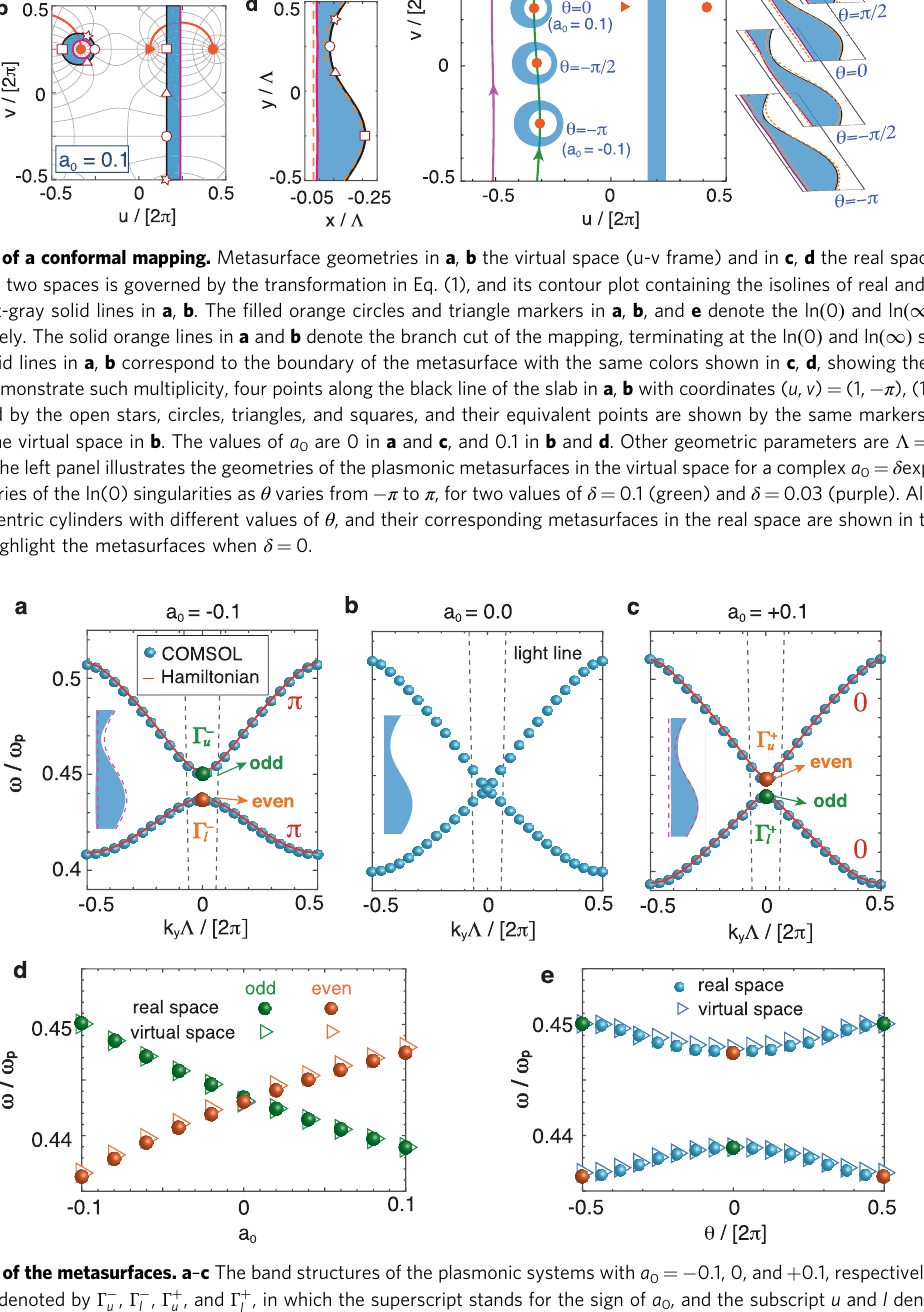
Fig. 2 Band structures of the metasurfaces. a – c The band structures of the plasmonic systems with a 0 = − 0.1, 0, and + 0.1, respectively. The states at the Γ -point in a and c are denoted by Γ (cid:2) Γ (cid:2) Γ þ Γ þ a u and l denotes the upper and u , l , u , and l , in which the superscript stands for the sign of 0 , and the subscript lower band. The gray dashed lines denote the light line, and the red solid lines are calculated via the Hamiltonian model. The insets in a – c show the schematics of the respective plasmonic metasurfaces, where the dashed lines highlight the metasurface boundary when a 0 = 0. The material of the metasurfaces is described by a lossless Drude model with plasma frequency ω p = 2 eV, while the background medium is vacuum. All other geometric parameters are the same as Fig. 1. d Eigenfrequencies at the Γ -point calculated in real space ( fi lled circles) and in the virtual space (triangles) with a 0 changing from − 0.1 to + 0.1. The color of the markers denotes the symmetry of the eigenstates, i.e., orange (green) represents the even (odd) mode. e The Γ -point eigenfrequencies calculated in the virtual space (triangles) and the real space ( fi lled circles) with δ = 0.1 as a function of θ , showing that the bandgap is always open in this case. All the calculations are for transverse magnetic modes ( H z polarization).